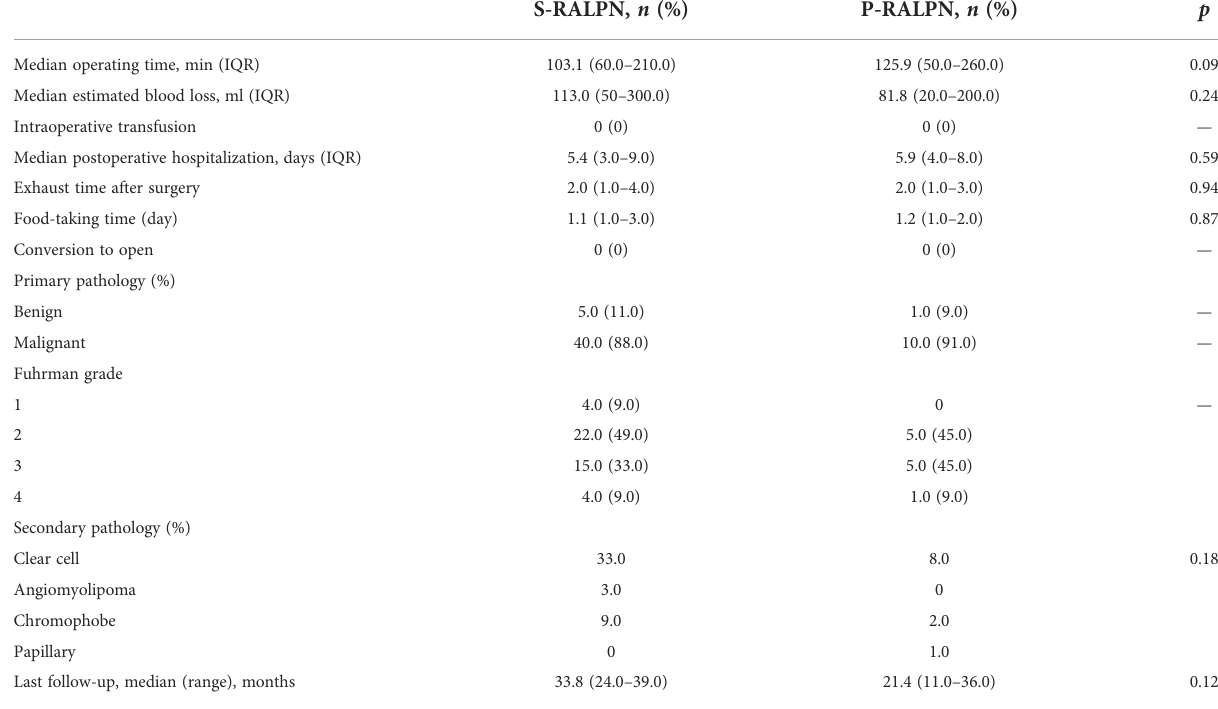
TABLE 2 Surgical and pathological outcomes.